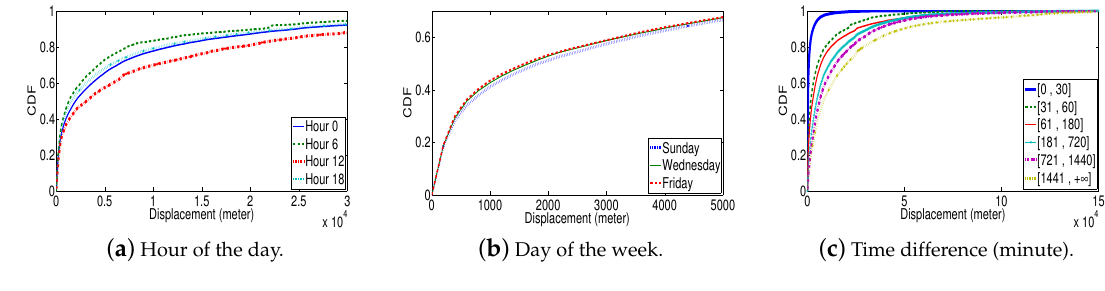
Figure 2. Temporal